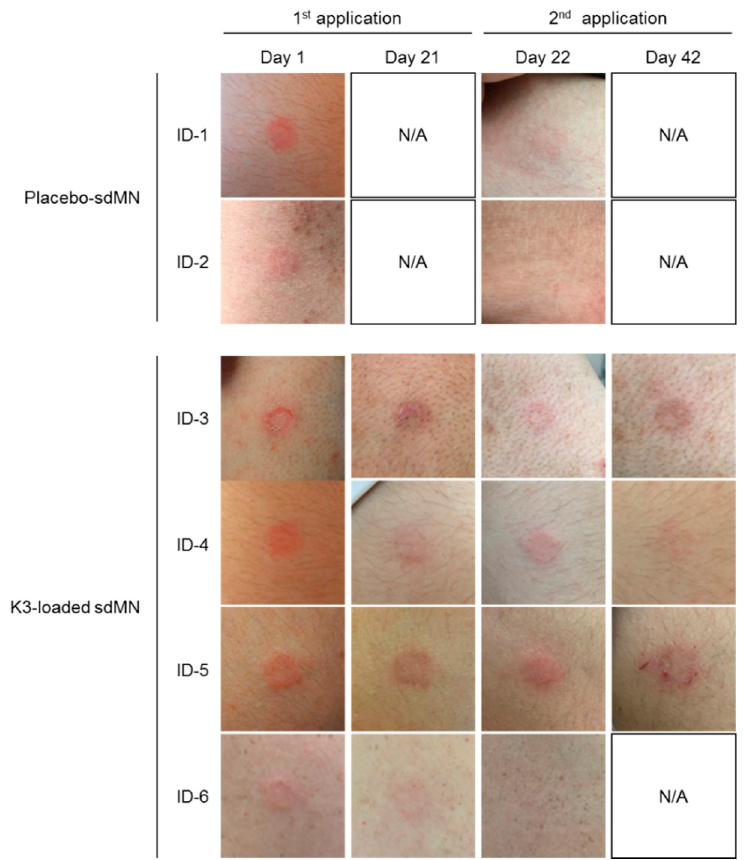
Figure 6. Safety evaluation of K3-loaded sdMN use in humans. Placebo-sdMN or K3-loaded sdMN were applied to the upper arm of participants twice every 3 weeks using an applicator. The day after administration (Day 1, Day 22) and 3 weeks after the first application (Day 21, Day 42); local skin reactions at the application site were observed.